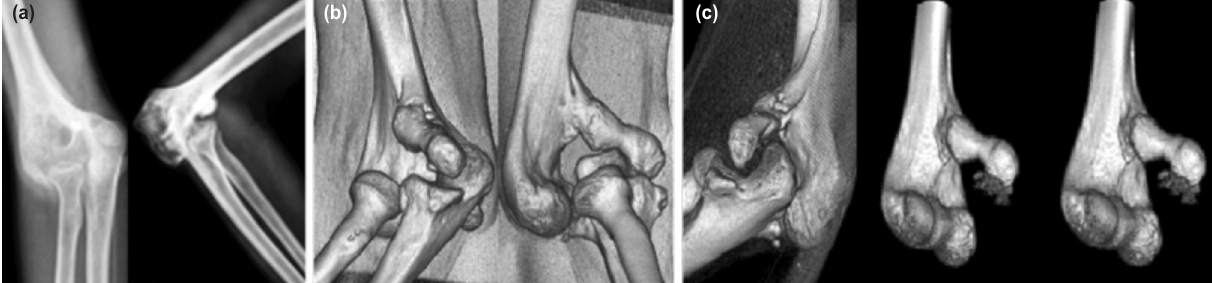
(a, b) AP and lateral radiograph and three dimensional reconstruction (3D) CT scan showing anterior dislocation of the elbow Fig. 1: joint. (c) 3D CT reconstruction with subtraction of radius and ulna anteroposterior and lateral views demonstrating anatomy of the distal humerus.